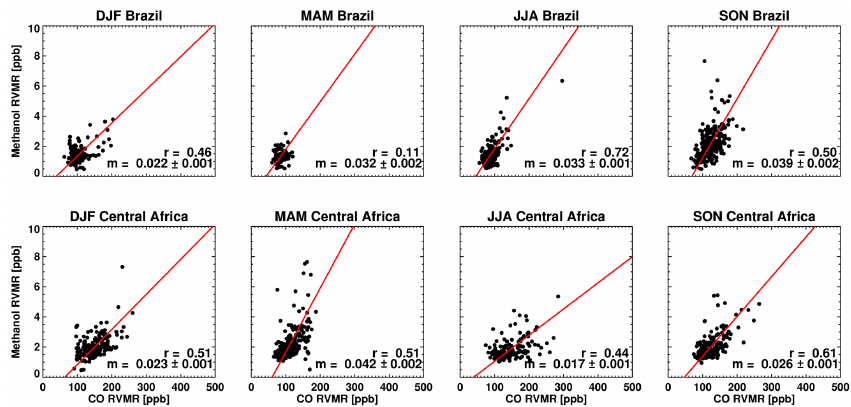
Fig. 12. Tropical methanol:CO correlations as measured by TES. Regions are as outlined in Fig. S4. The TES CO RVMR is calculated by applying the TES methanol RVMR weighting function to the retrieved CO profile. Slopes are calculated using reduced major axis regression.